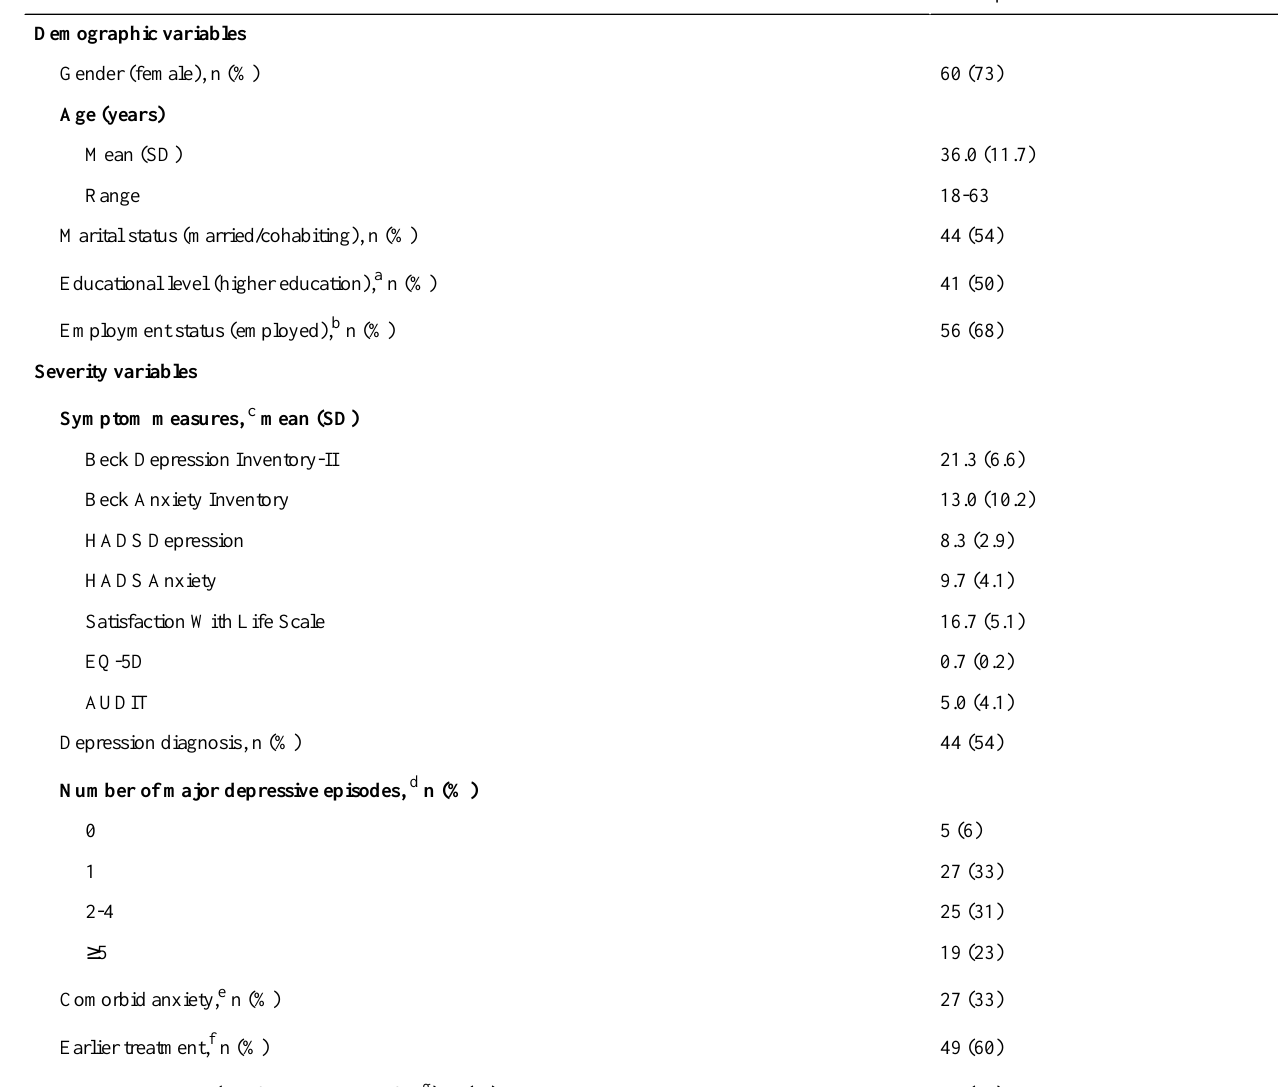
Table 2. Participant characteristics